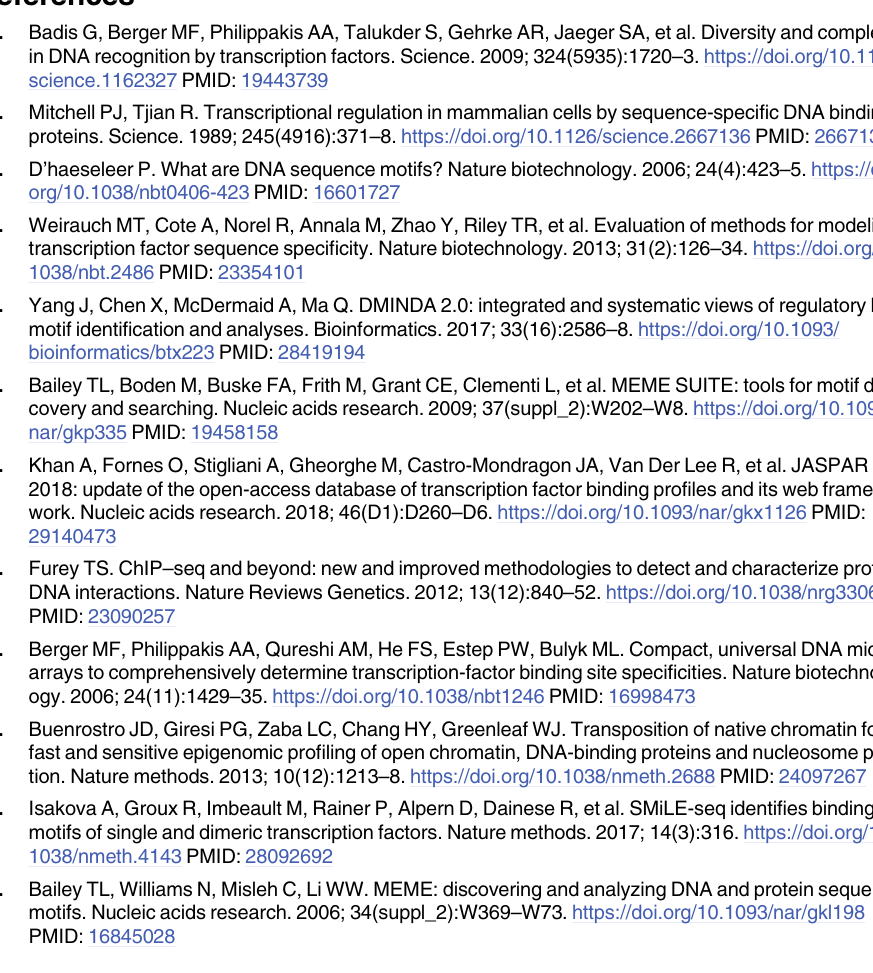
S2 Table. The SNP list of Autoimmune, Myeloma, and CLL diseases. (XLSX) S3 Table. Motif visualization of three examples (BATF, CTCF, and NFYB).